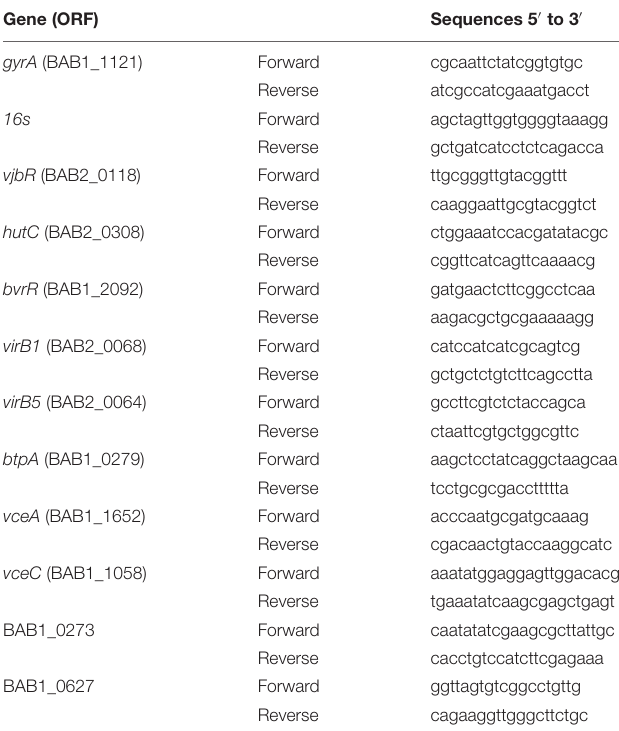
TABLE 3 | Primers used in this study for qPCR assays. Gene